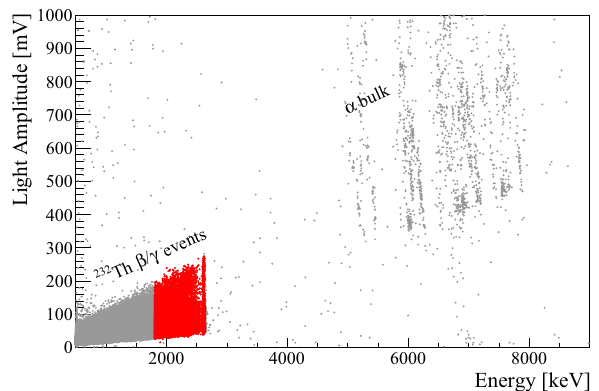
Fig. 6 The light recorded by the LD placed on top of the ZnSe is reported as a function of the heat released in the crystal. The heat axis is energy-calibrated using the most intense γ peaks produced by the 232 Th source. On the contrary, the light axis is not energy-calibrated (broadening the β/γ and α bands). Red: pulses that pass the selection criteria to produce the signal templates, both for the heat and the light detectors. In this plot, data from all crystals are shown